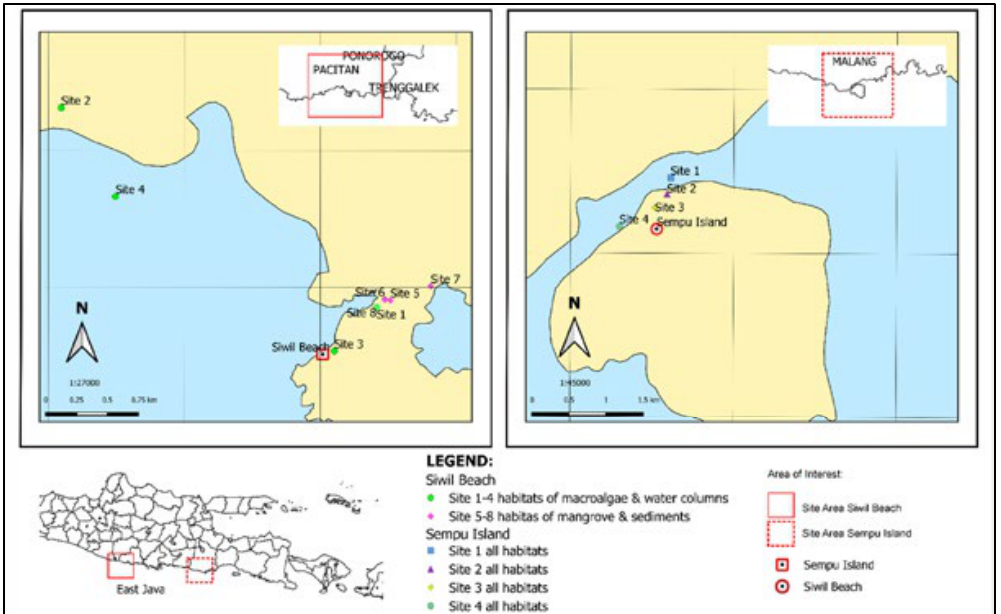
Fig. 1(b): The sampling sites details of Siwil Beach and Sempu Island, in Indonesia